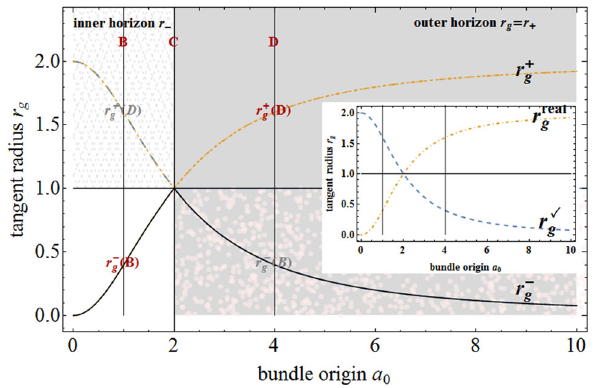
Fig. 17 Tangent radius r ± g of Eq. (25) as a function of the tangent spin a g . Inside panel: ( r real g , r (cid:2) g ) . The gray region represents SNS with a 0 > 2 M and the shaded regions are values of r (cid:2) g . The models XX are also shown, where X = { A , B , C , D } is considered in Table 3 and Fig. 15